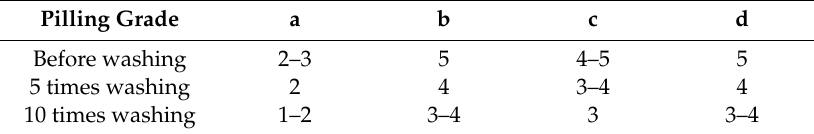
Table 1. Pilling grade of cotton fabric before and after five and ten washing cycles.